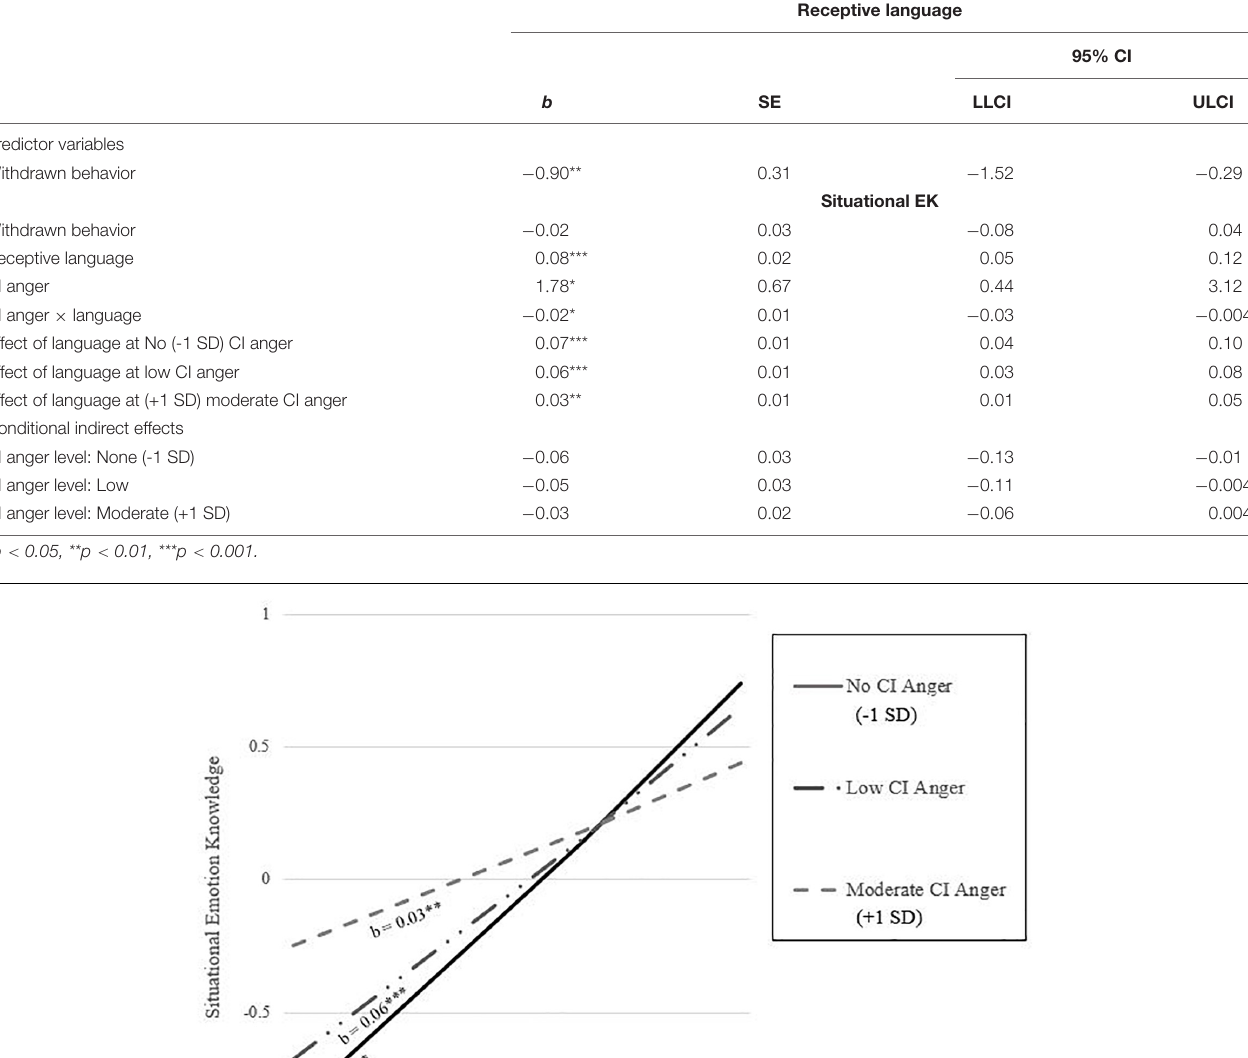
Receptive language